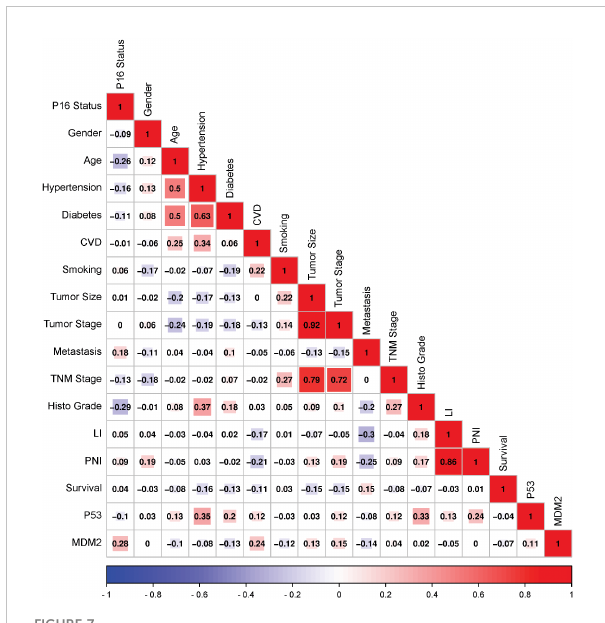
FIGURE 7 Correlation matrix among MDM2 and P53 expressions and various demographic and Clinical characteristics of the HNSCC patients. Analysis was performed by Pearson ’ s Correlation, p ≤ 0.05. Red indicates a positive correlation, and blue indicates a negative correlation. Darker colors are related to stronger correlation coef fi cients. CVD, Cardiovascular diseases; LI, Lymphovascular invasion; PNI, Perineural